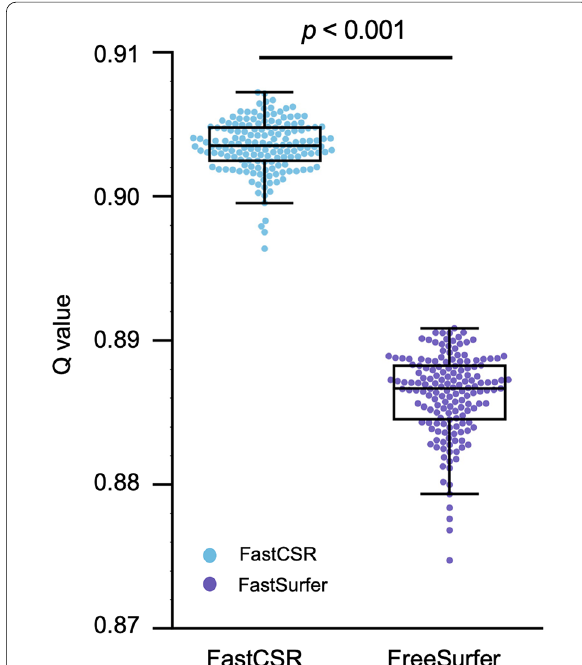
Fig. 5 Surfaces reconstructed by FastCSR and FreeSurfer show comparable mesh quality. To assess the mesh quality of the FastCSR surface, we estimated the mesh quality in terms of Q value in the validation set. The Q values of FastCSR (blue dots) and FreeSurfer (purple dots) are illustrated using swarm plots, with the means of each distribution depicted by boxplots with boxes marks the high and low quartiles and whiskers indicating the minimum and maximum values. The Q values obtained with FastCSR ( Q FastCSR 0.903 0.002) are significantly higher than those = ± of FreeSurfer ( Q FreeSurfer 0.886 0.003; two-tailed paired t -test, = ± t (161) 122.008, p 1.462 10 –160 ), indicating greater mesh quality = = × achieved with our